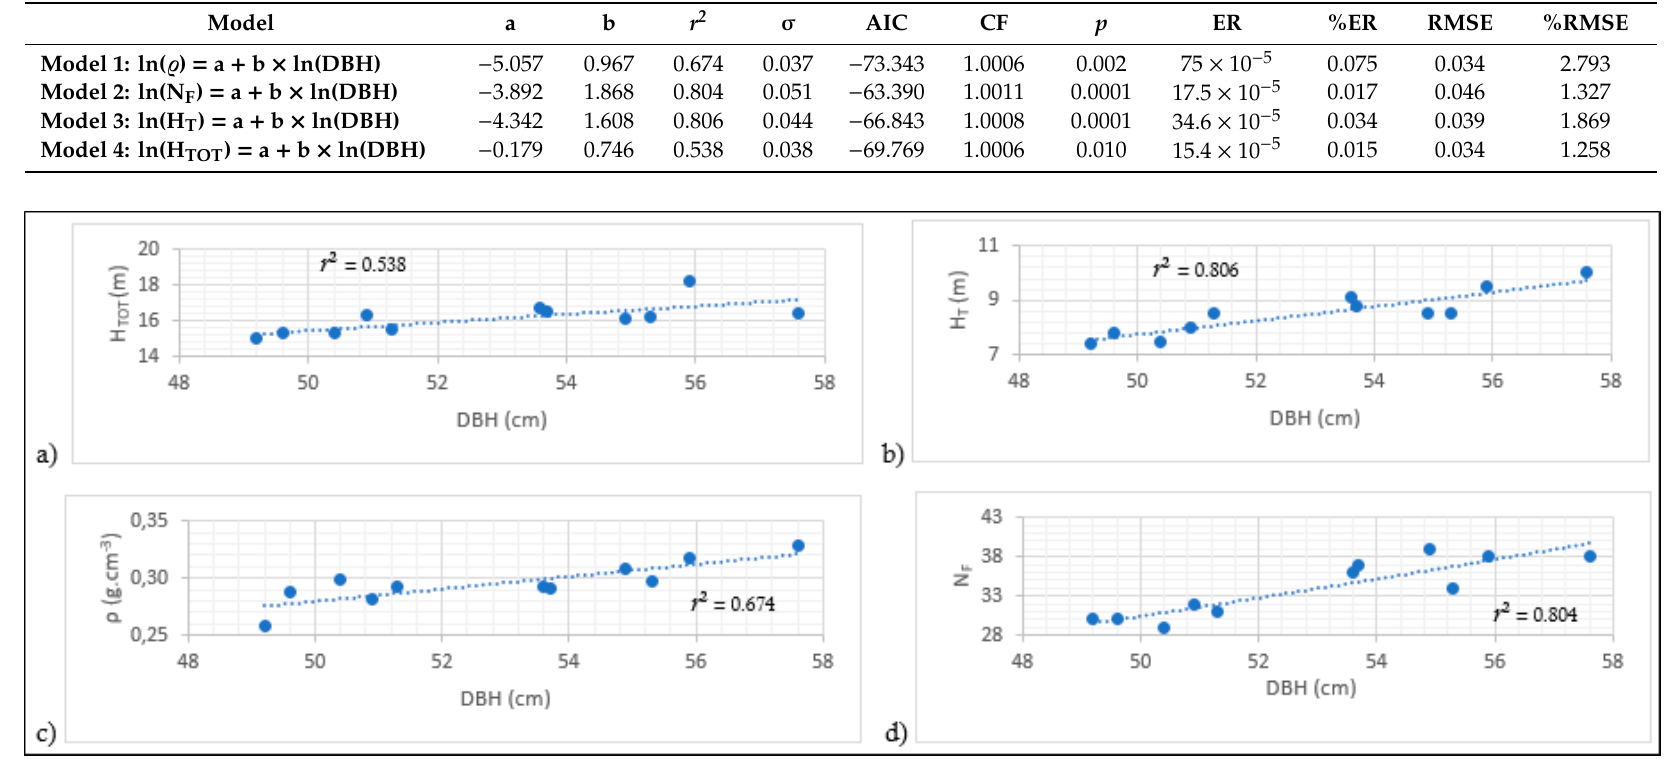
Figure 3. Allometric relationships between the variables and the DBH of the 11 oil palms used in this study to develop local biomass models: ( a ) relationship between total height vs. DBH; ( b ) relationship between stem height vs. DBH; ( c ) relationship between infra-density vs. DBH; and ( d ) relationship between number of leaves vs. DBH.